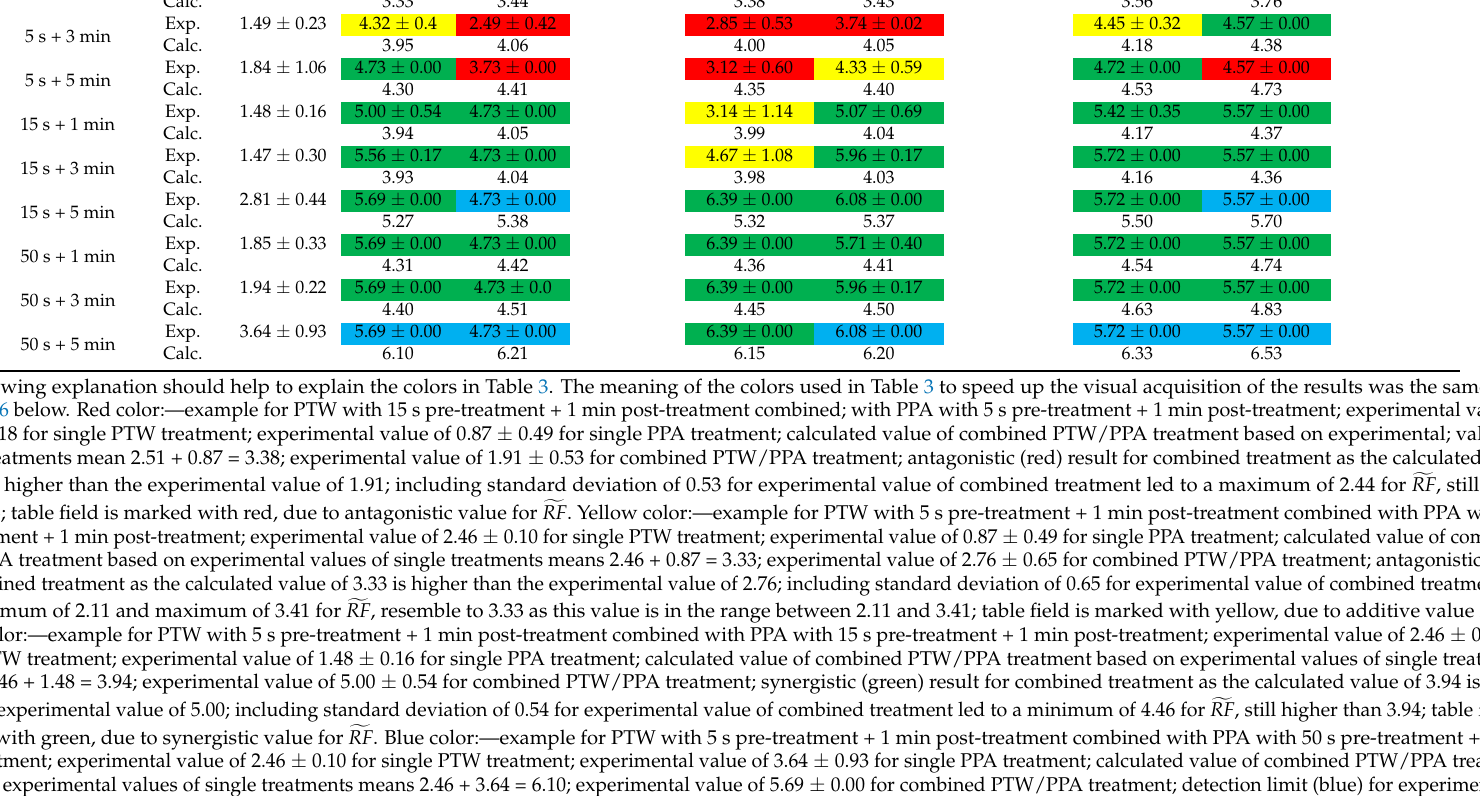
Table 3. Experimental ( (cid:102) RF comb ) and calculated ( (cid:102) RF add ) data of separated and combined use of PPA (plasma-processed air) and PTW (plasma treated water) under different pre- and post-treatment times for antimicrobial effects on P. carotovorum . Color code for effects of combined PTW/PPA treatments: red = antagonistic, yellow = additive, green = synergistic, blue = detection limit reached within the experiments. w/o = without. Exp. = experimental, Calc. = calculated. PTW PPA w/o 5 s + 1 min 5 s + 3 min Exp. w/o